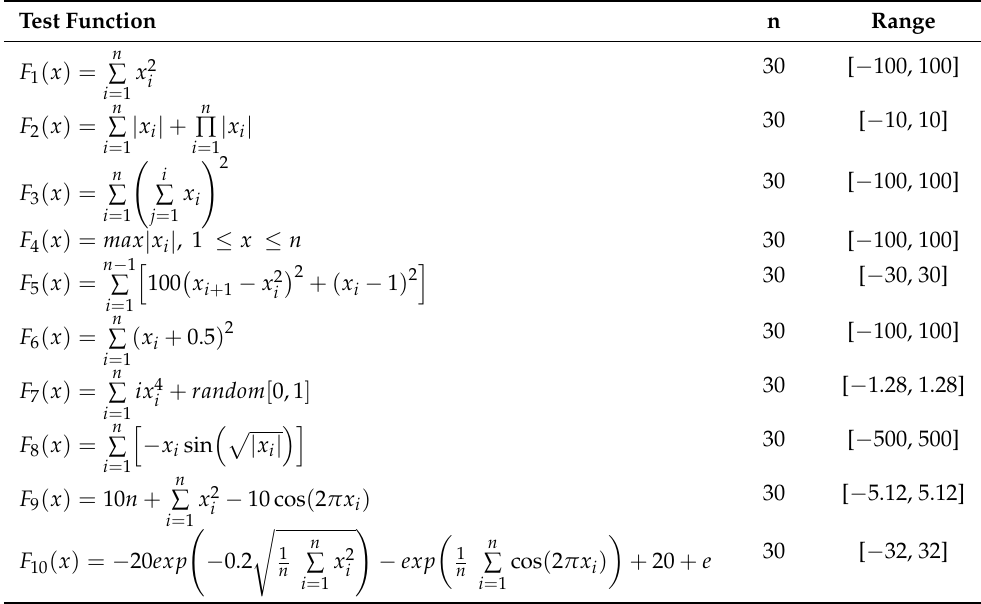
Table 1. Definitions of benchmark functions.